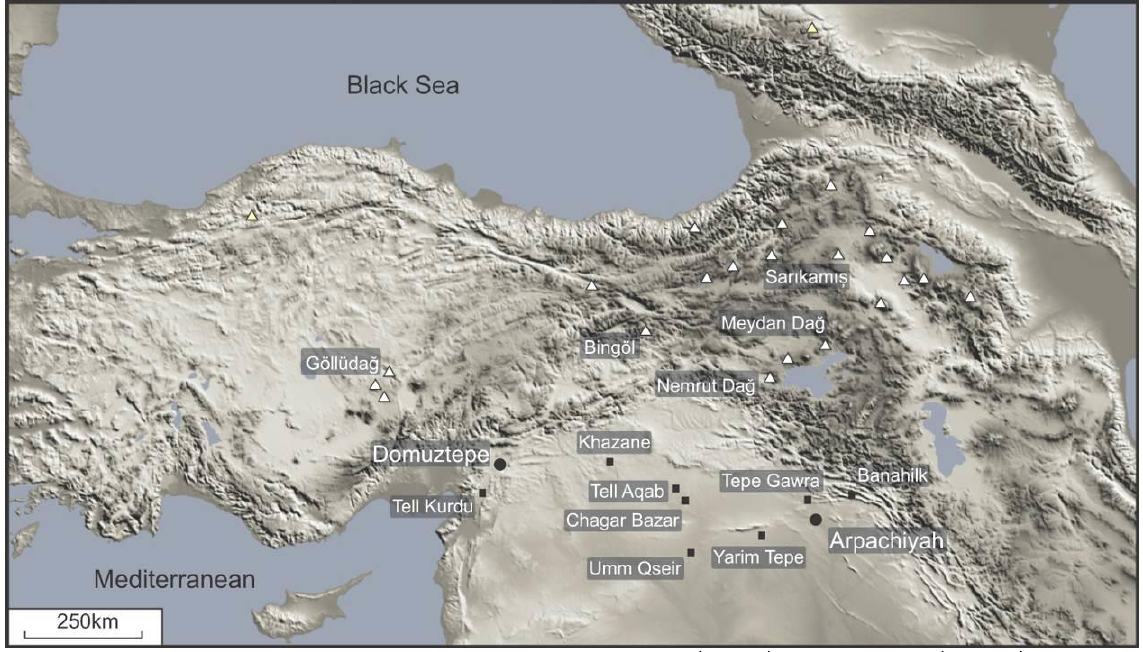
Figure 1. Map showing the location of Arpachiyah and Domuztepe (circles) and other sites (squares) mentioned in the text in relation to obsidian sources (open triangles) (Source Stuart